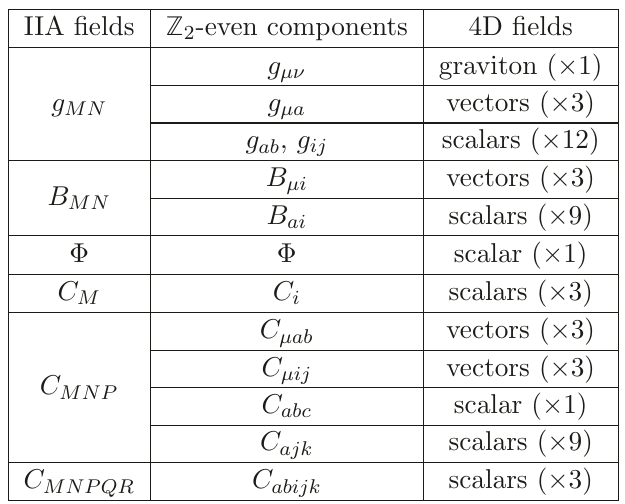
Table 4 . The effective 4D bosonic field content of type IIA supergravity on a compact 6d manifold. Please note that the orientifold truncation selects the field components which are even w.r.t. the